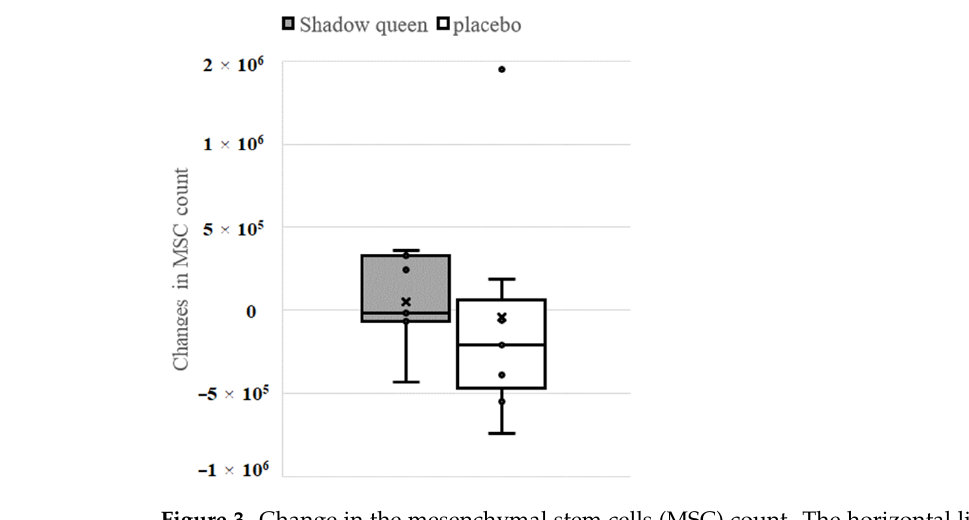
Figure 3. Change in the mesenchymal stem cells (MSC) count. The horizontal line in the boxplot represents the median, and the × mark represents the mean.